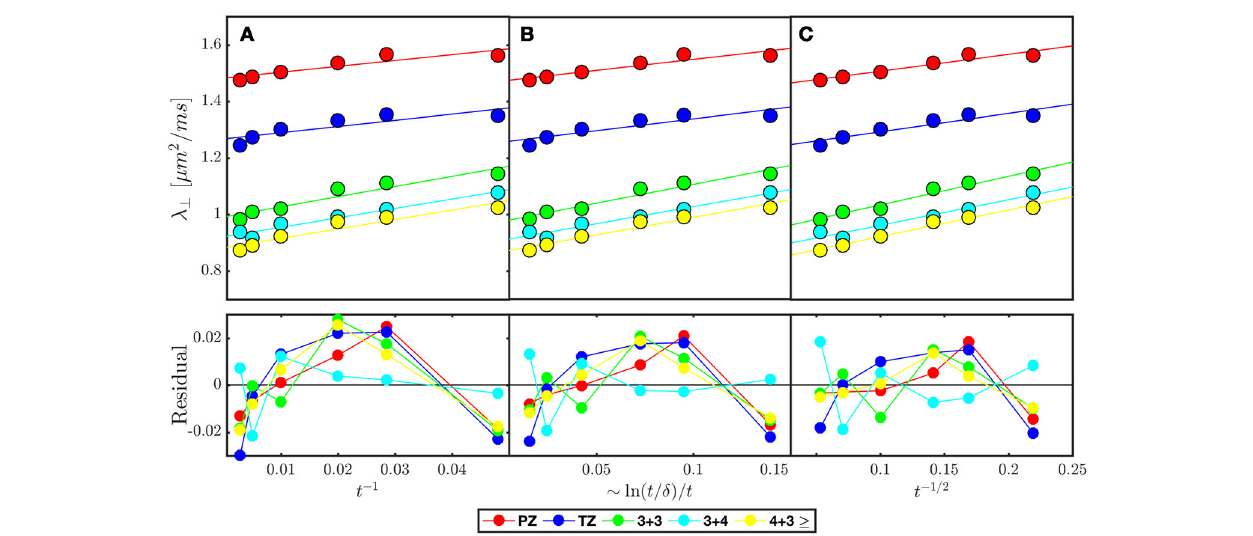
FIGURE 7 | Model selection in prostate cancer of various Gleason Scores based on disorder class from ROI averaged across 38 patients published in Lemberskiy et al. [ 17] Radial diffusivity ( λ ) is fitted (solid line over each ROI) by the associated power law tail for (A) ordered or hyper-uniform restrictions Equation (5), (B) ⊥ short-range disorder in 2-dimensions Equation (6), and (C) extended-range disorder Equation (7). The residual is included to emphasize systematic differences between the tested disorder classes. λ and the residual is plotted against the corresponding power laws of t , in which a linear dependence would indicate stronger ⊥ association with the given disorder class ( Table 2 ).